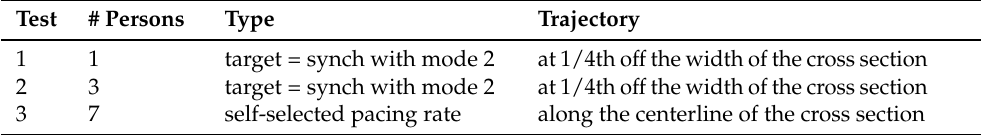
Table 4. Information on the tests performed on the Eeklo